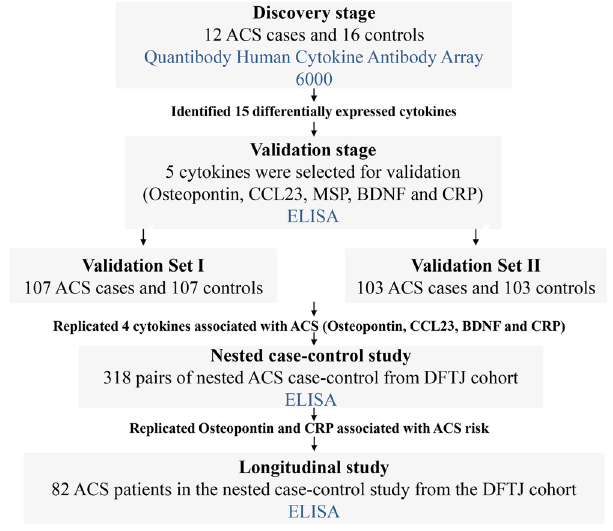
Figure 3. Flowchart of the